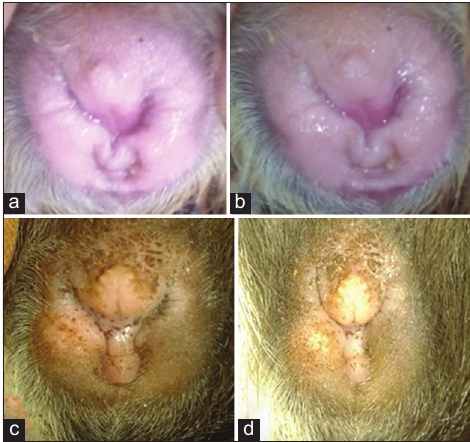
(Figure-2a), there were superficial nucleated cells and erythrocytes.